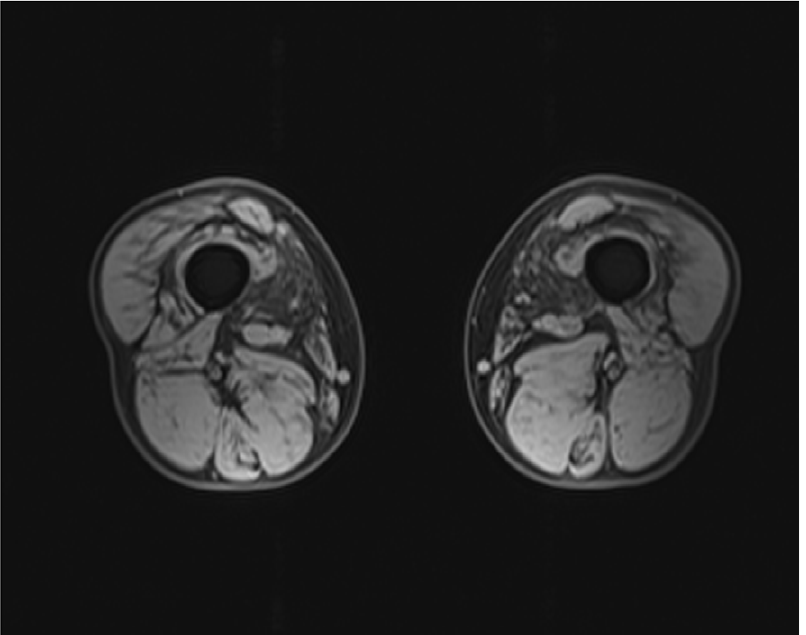
Figure 2. Muscle MRI imaging of the index case showing slight atrophy in the lateral and medial muscles of the thigh. doi:10.1371/journal.pone.0039288.g002 PLoS ONE |